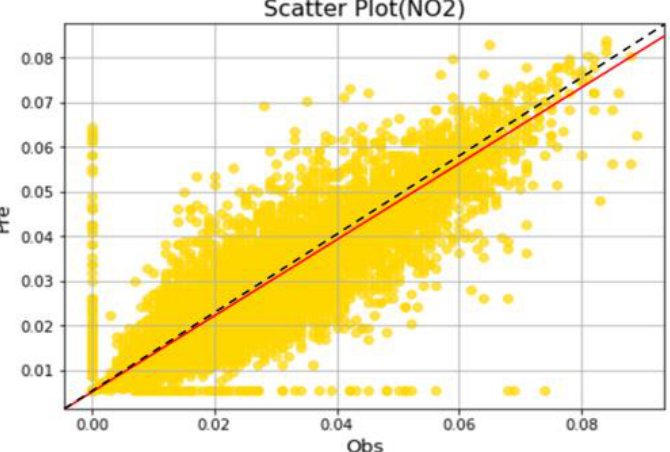
Figure 11. Comparison results of predicted nitrogen dioxide with observations. The regression line of observed and predicted data is indicated in red.